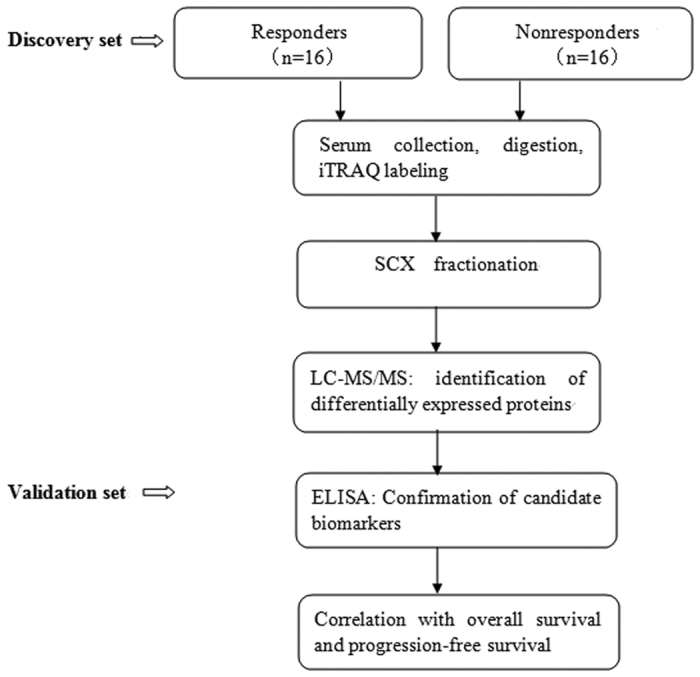
The workflow of how to discover and validate biomarkers.